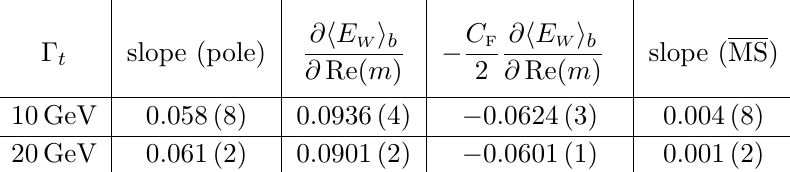
i in the pole-mass scheme and the derivative terms W